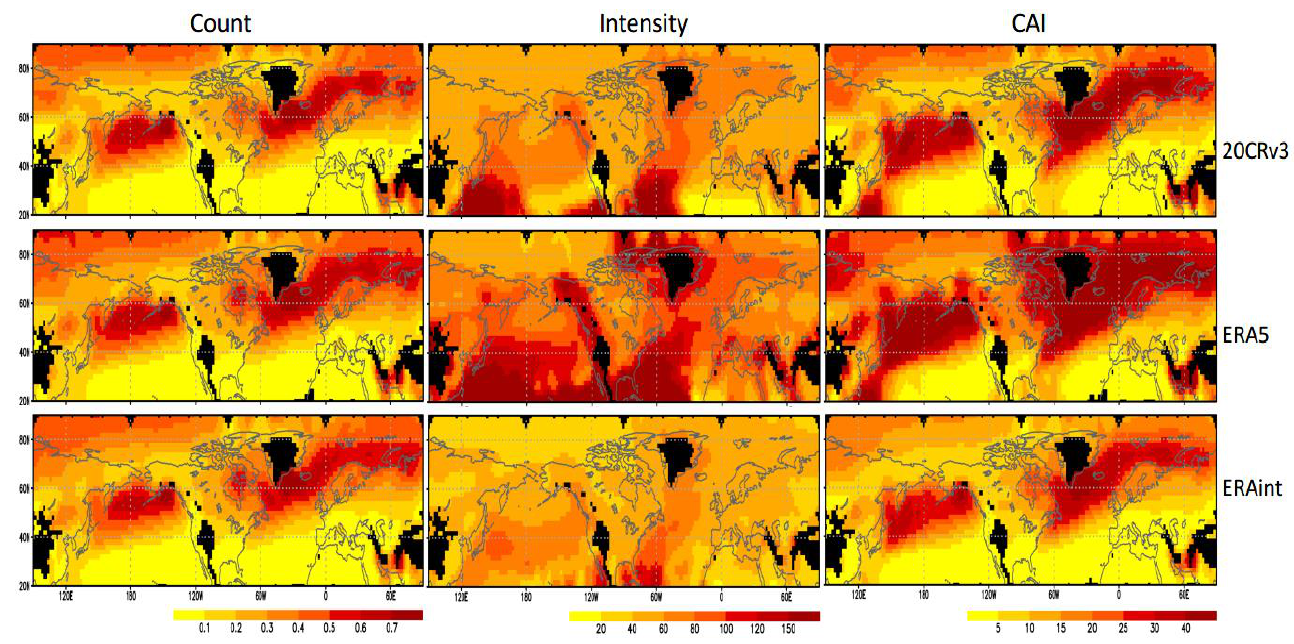
Figure 1. Annual climatologies of the cyclone count (per 250 km grid-box; ( left panels )), intensity (unit: 10 −5 hPa km −2 ; ( middle panels )), and CAI (unit: 10 −5 hPa km −2 per 10 6 km 2 ; ( right panels )) over the period 1981 – 2010 for 20CRv3 ( top panels ), ERA5 ( middle panels ) and ERAint ( lower panels ).